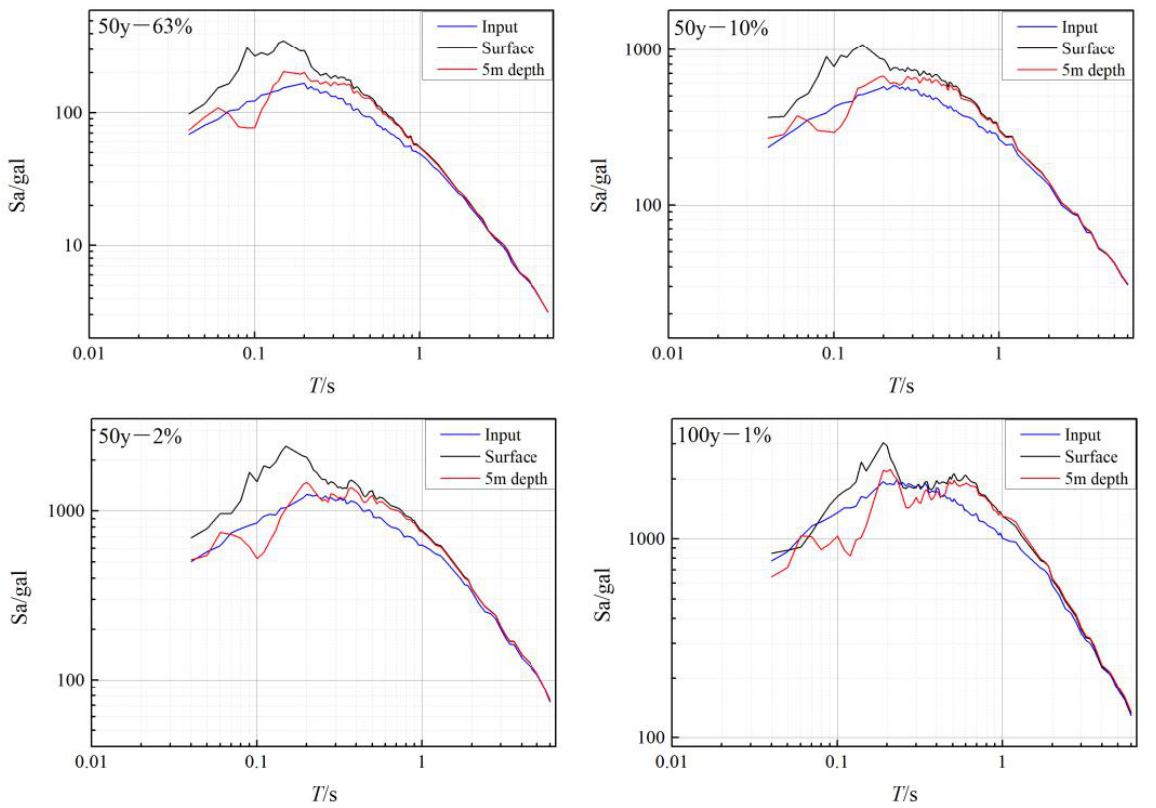
Figure 12. Comparison map of acceleration spectrum of pebble-top interface, site surface, and acceleration response spectrum of bedrock.